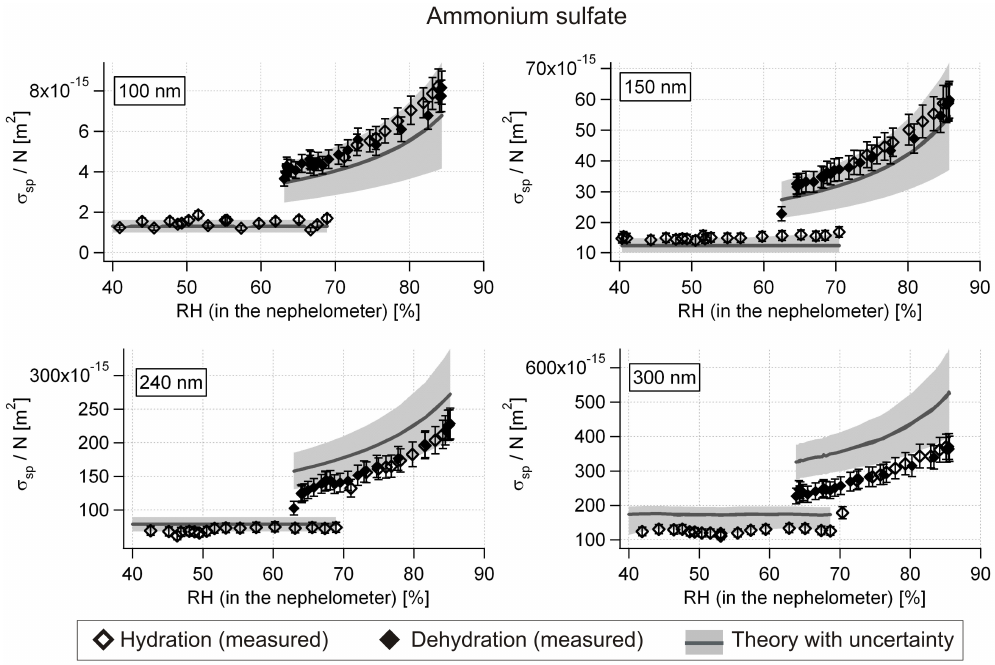
Fig. A2. Scattering coefficient normalized by the number concentration vs. RH in the nephelometer of quasi monodisperse ammonium sulfate particles with dry diameters between 100 and 300nm. The grey lines represent the predicted values, with their corresponding uncertainties. The black open diamonds show the measured σ sp /N while hydrating, whereas the black closed diamonds illustrate the corresponding dehydration values. The black error bars illustrate the measurement uncertainty of the nephelometer.